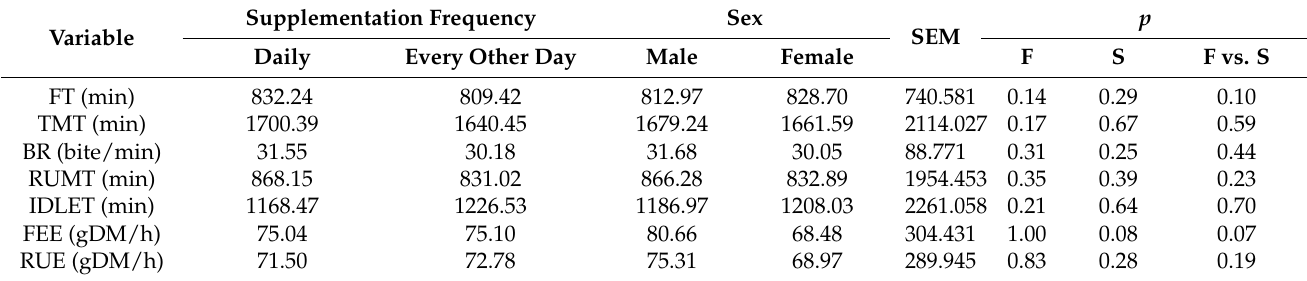
Table 4. Intake behavior and feeding efficiency of sheep submitted to intermittent supplementation on Masai grass